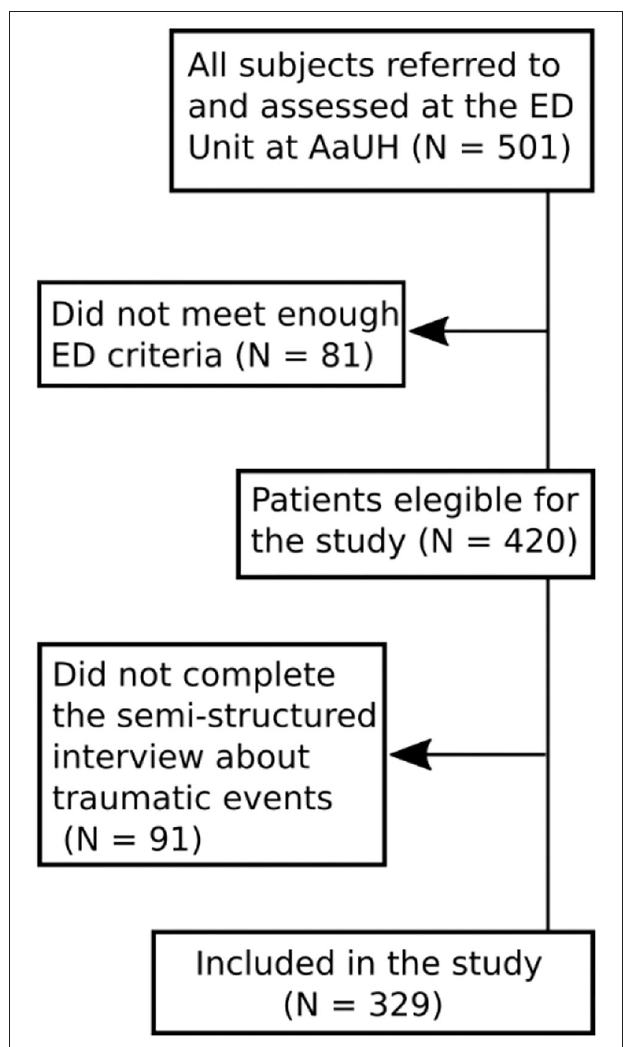
FIGURE 1 | Flow chart showing study inclusion.